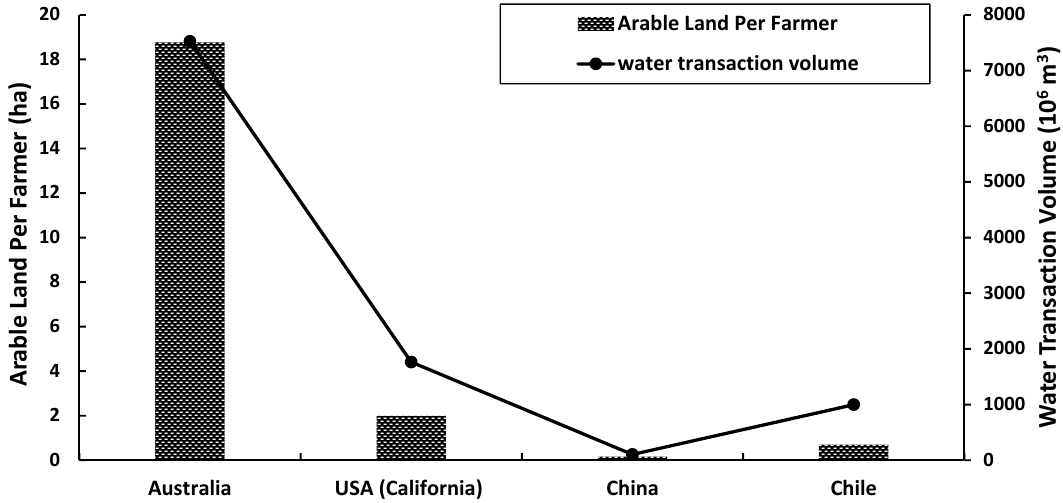
Figure 8. Transaction water volume and ALPF in developed and developing countries. Note: The data of ALPF and the transaction water volume in Australia, California, and Chile are from Wu (2015), the transaction water volume in China is from China Water Exchange (2017), and the ALPF is from Wu